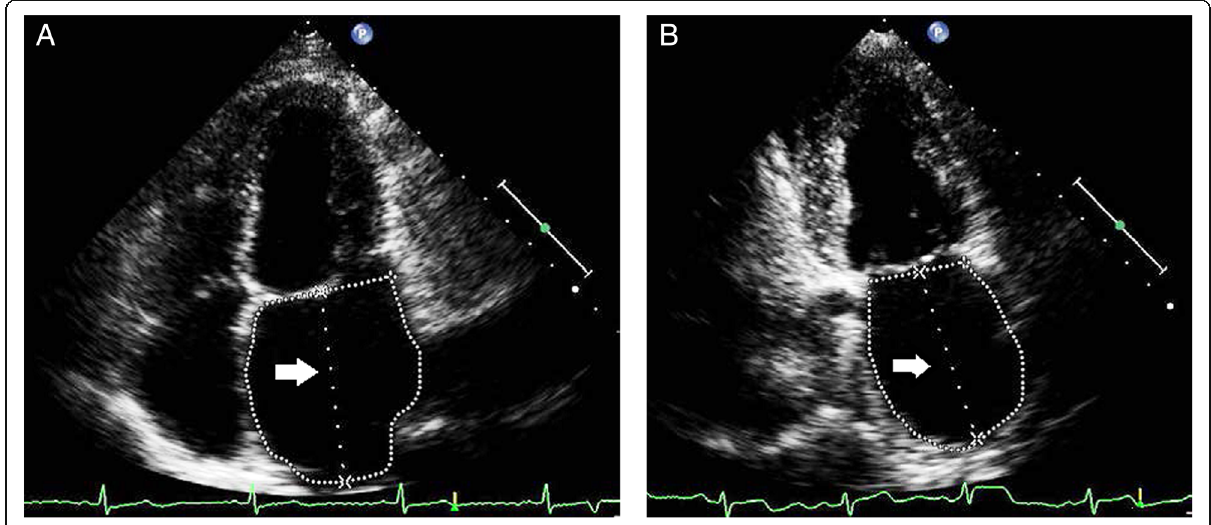
Fig. 1 Measurement of left atrial volume from the area-length method using the apical four-chamber ( a ) and apical two-chamber ( b ) views. The length ( L ) is measured from the back wall to the line across the hinge points of the mitral valve (arrow). The shorter ( L ) from either the A4C or A2C is used in the